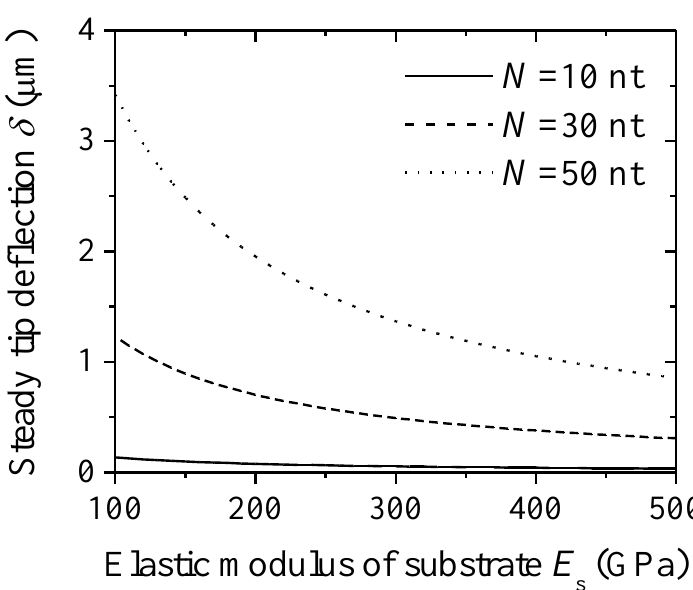
Figure 6. Steady tip deflection of a DNA-microcantilever sensor as a function of the elastic modulus of a substrate under different nucleotide numbers.